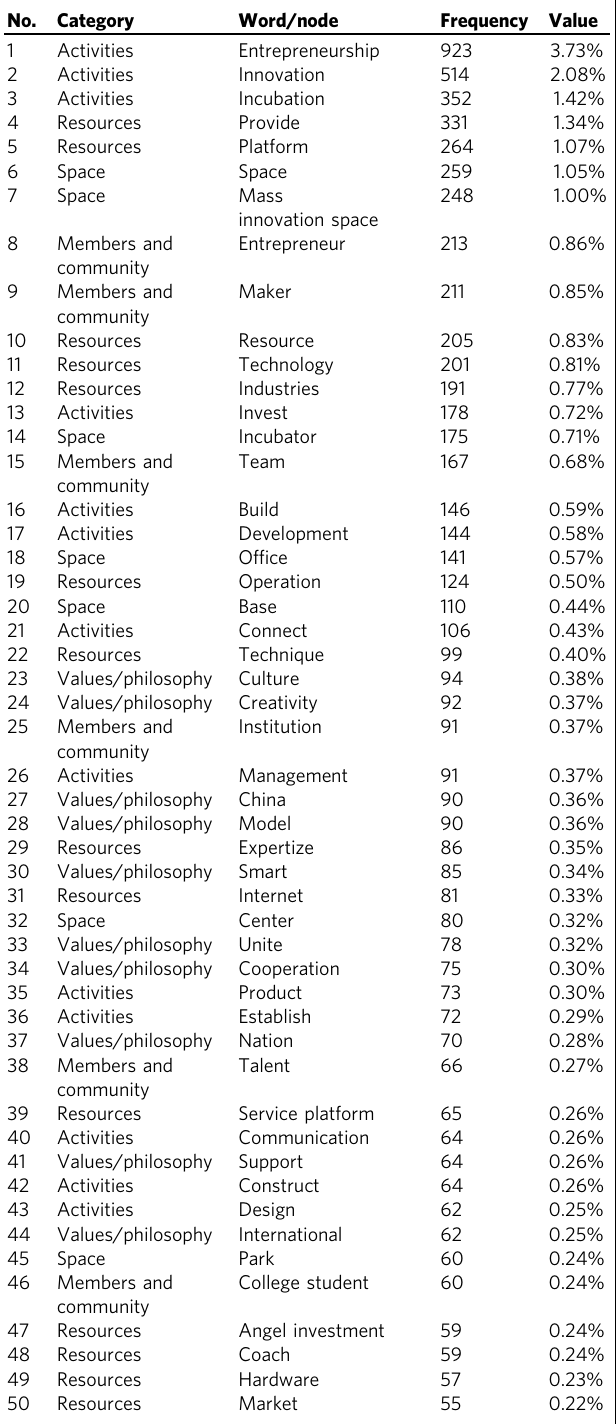
Table 1 Descending list of the 50 most frequently appearing